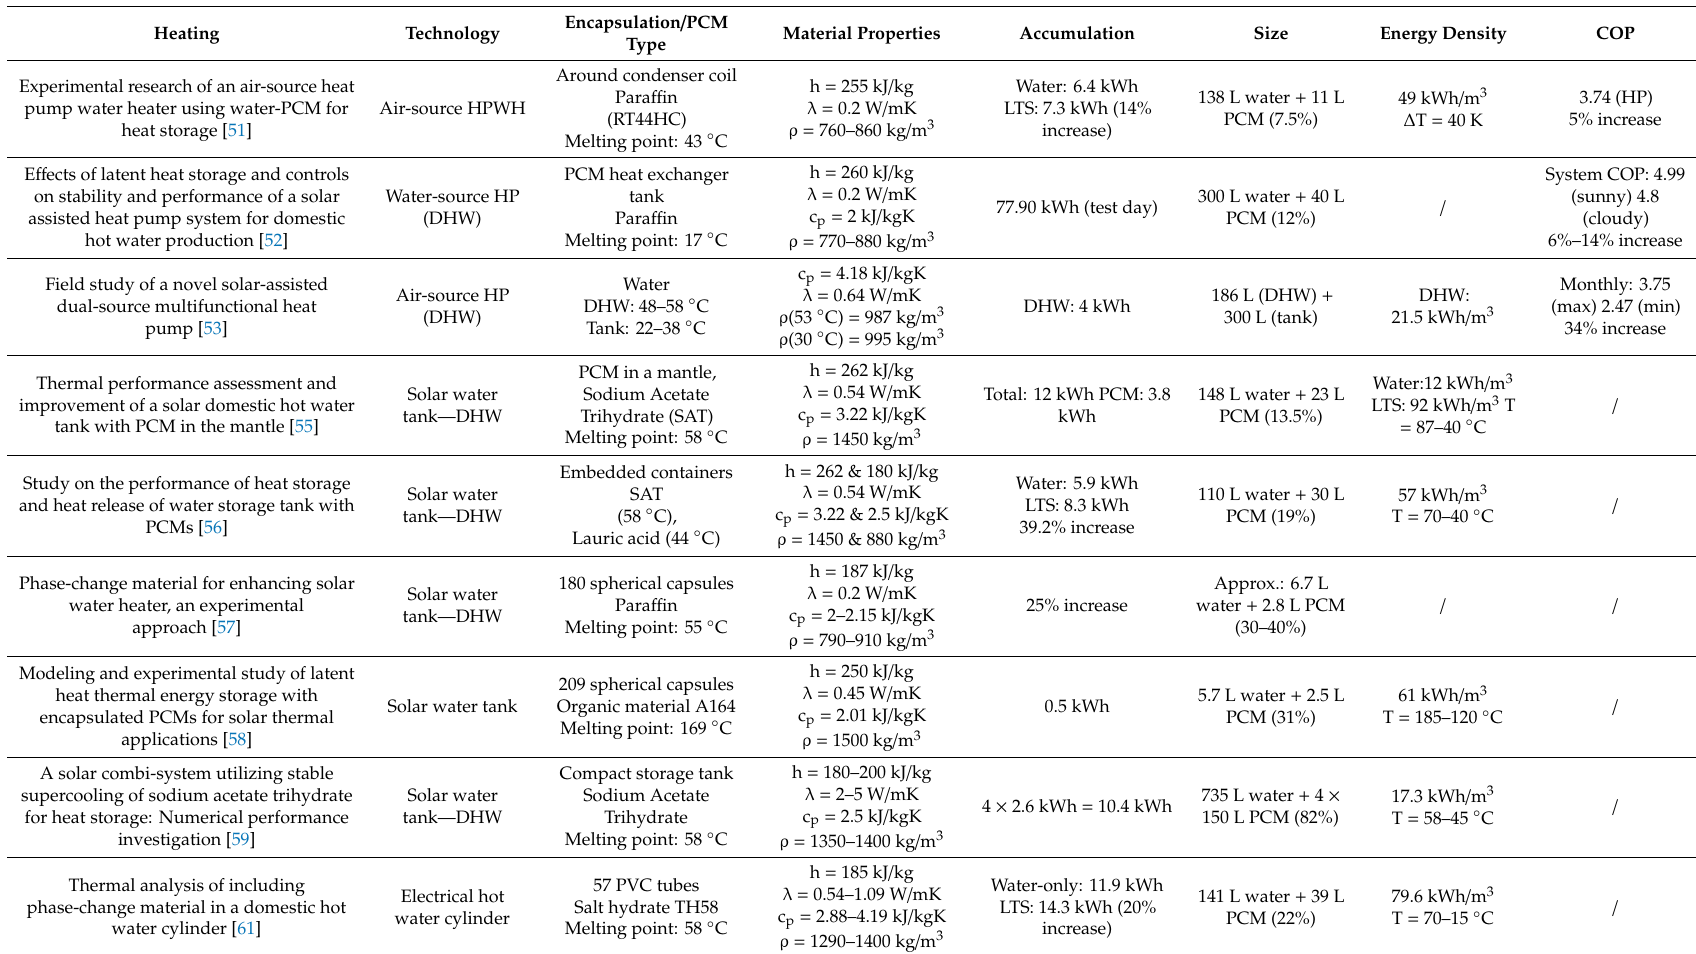
Table 2. Overview of heating technologies with